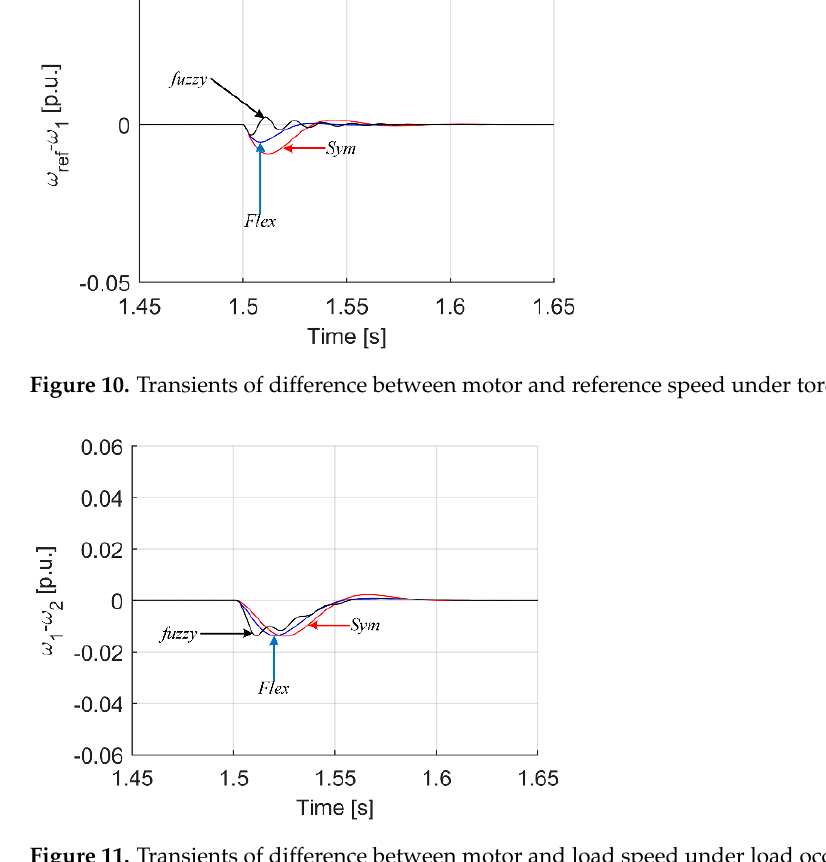
Figure 11. Transients of difference between motor and load speed under load occurrence.